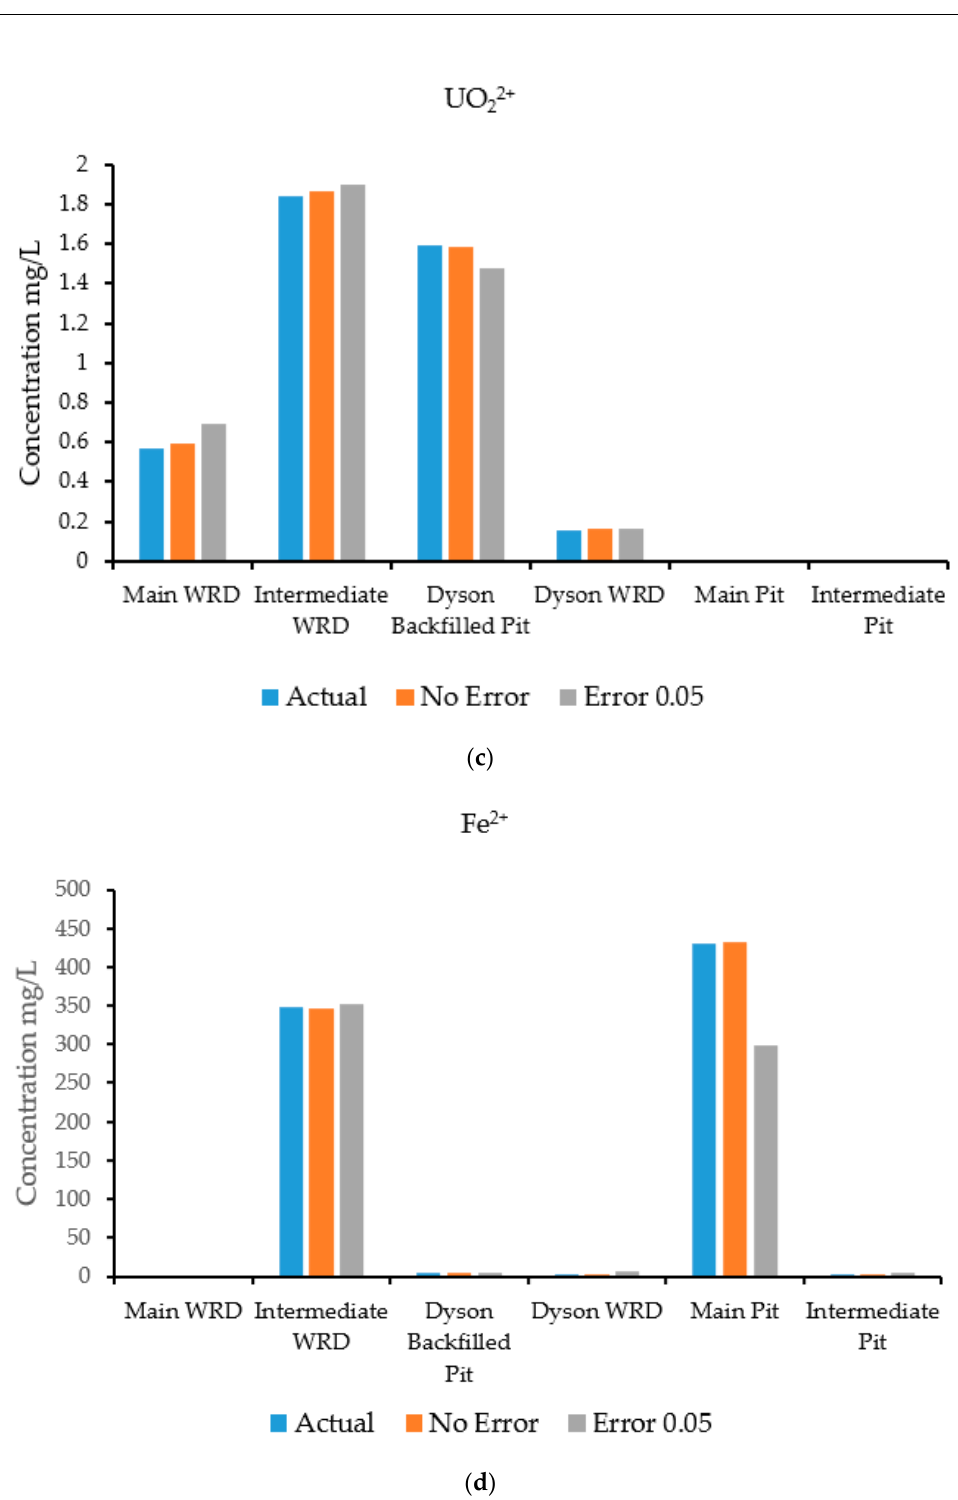
Figure 11. Comparison of species concentrations at sources with a perturbed error of 0.05: ( a ) Cu 2+ species; ( b ) SO 42+ species; ( c ) UO 22+ ; ( d ) Fe 2+ species.